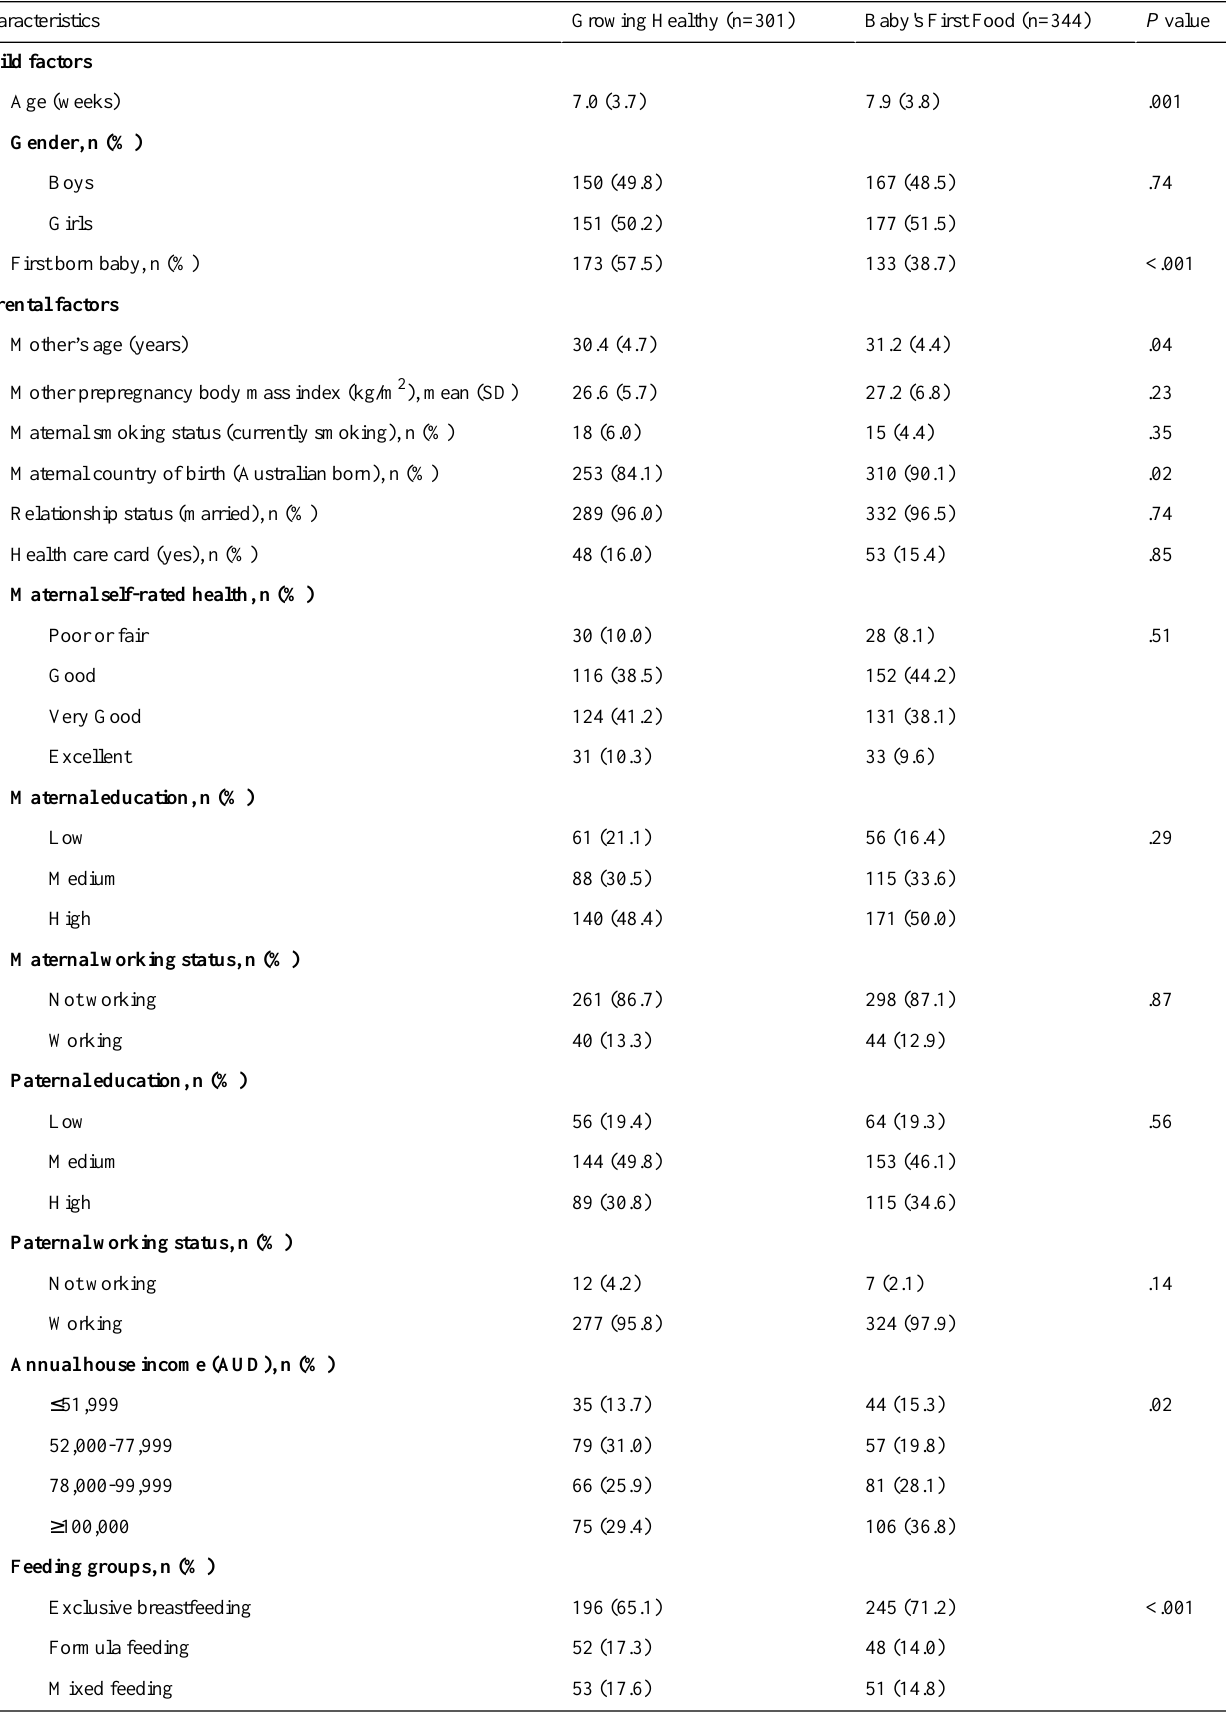
Table 1. Sociodemographic characteristics of the Baby's First Food and Growing Healthy samples at